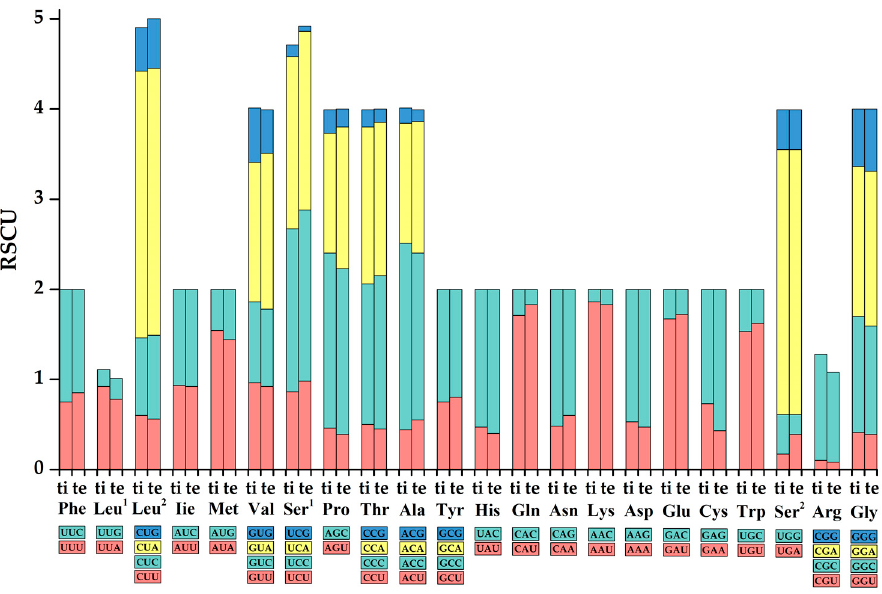
Figure 3. The base composition and the relative synonymous codon usage values of Exostoma tibetanum (ti) and Exostoma tenuicaudatum (te). Blue, yellow, green, and pink represent the first, second, third, and fourth type of each amino acid, respectively.